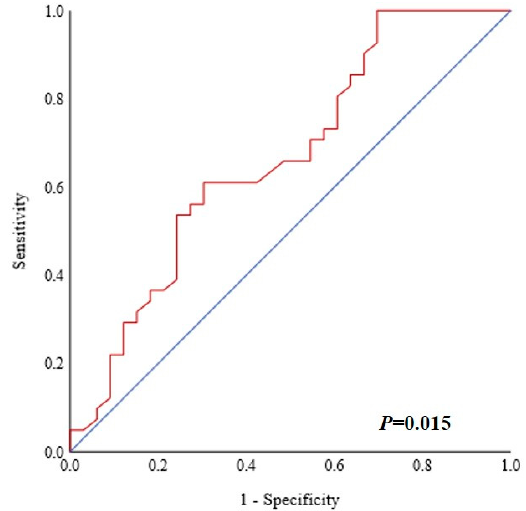
Figure 2. Receiver operating characteristic (ROC) curve showing the maximum standardized uptake value (SUV max ) and bone invasion. The best cutoff was determined to be 9.5. The area under the curve (AUC) was 66.5% (95% CI 53.9%–79.1%) ( p = 0.015).